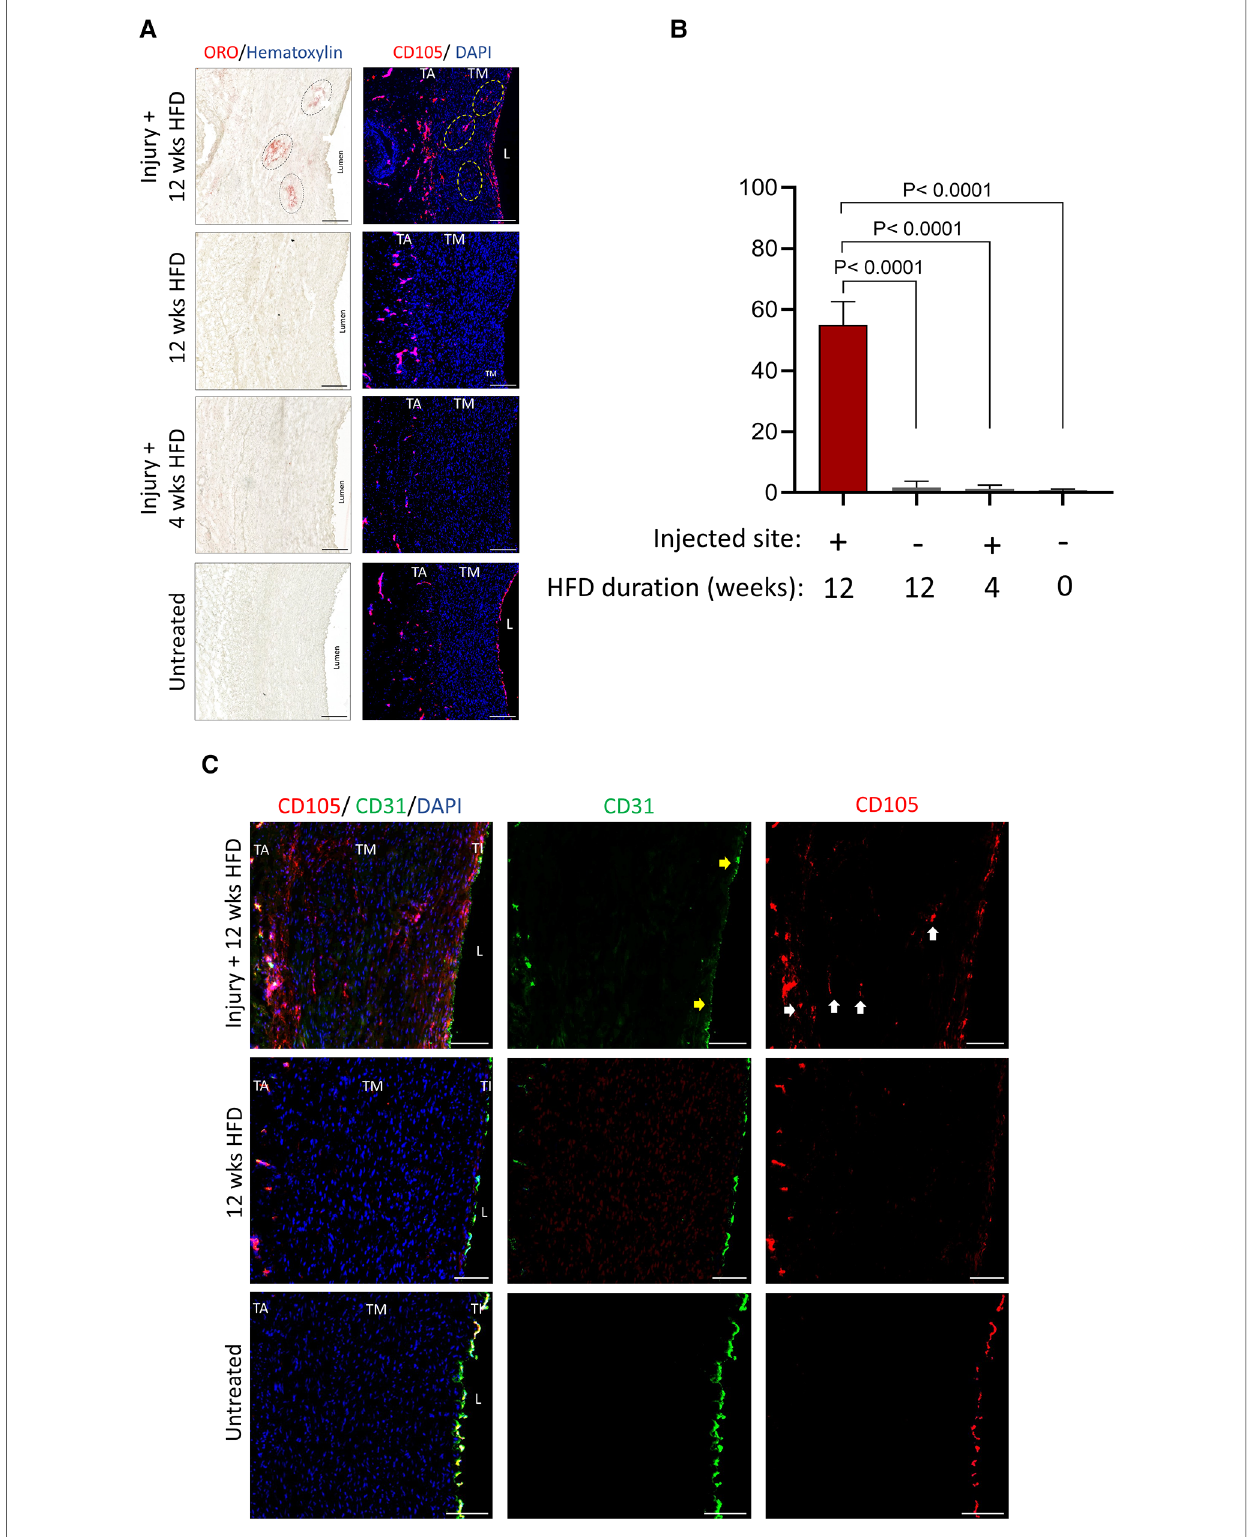
FIGURE 4 Presence of VV at the injury sites in the tunica media under prolonged hyperlipidemia. ( A ) Corresponding aortic tissue sections positive for lipid clusters (described in Figure 3A) were stained by immuno fl uorescence for detecting VV (CD105, red), and nuclei DAPI (blue). Scale bar: 100 µm. ( B ) Bar graphs show quanti fi cation of the area positive for VV in the indicated groups (mean±SEM, n =3, **** p <0.0001 by one-way ANOVA test). ( C ) Tissues as shown in ( A ) were stained for VV (CD105, red) and mature endothelia (CD31, green). Representative micrographs are shown. Arrows: areas positive for VV, lacking the expression of CD31, a marker for mature endothelia. TA, tunica adventitia; TM, tunica media; TI, tunica intima; L, lumen. Scale bar: 100